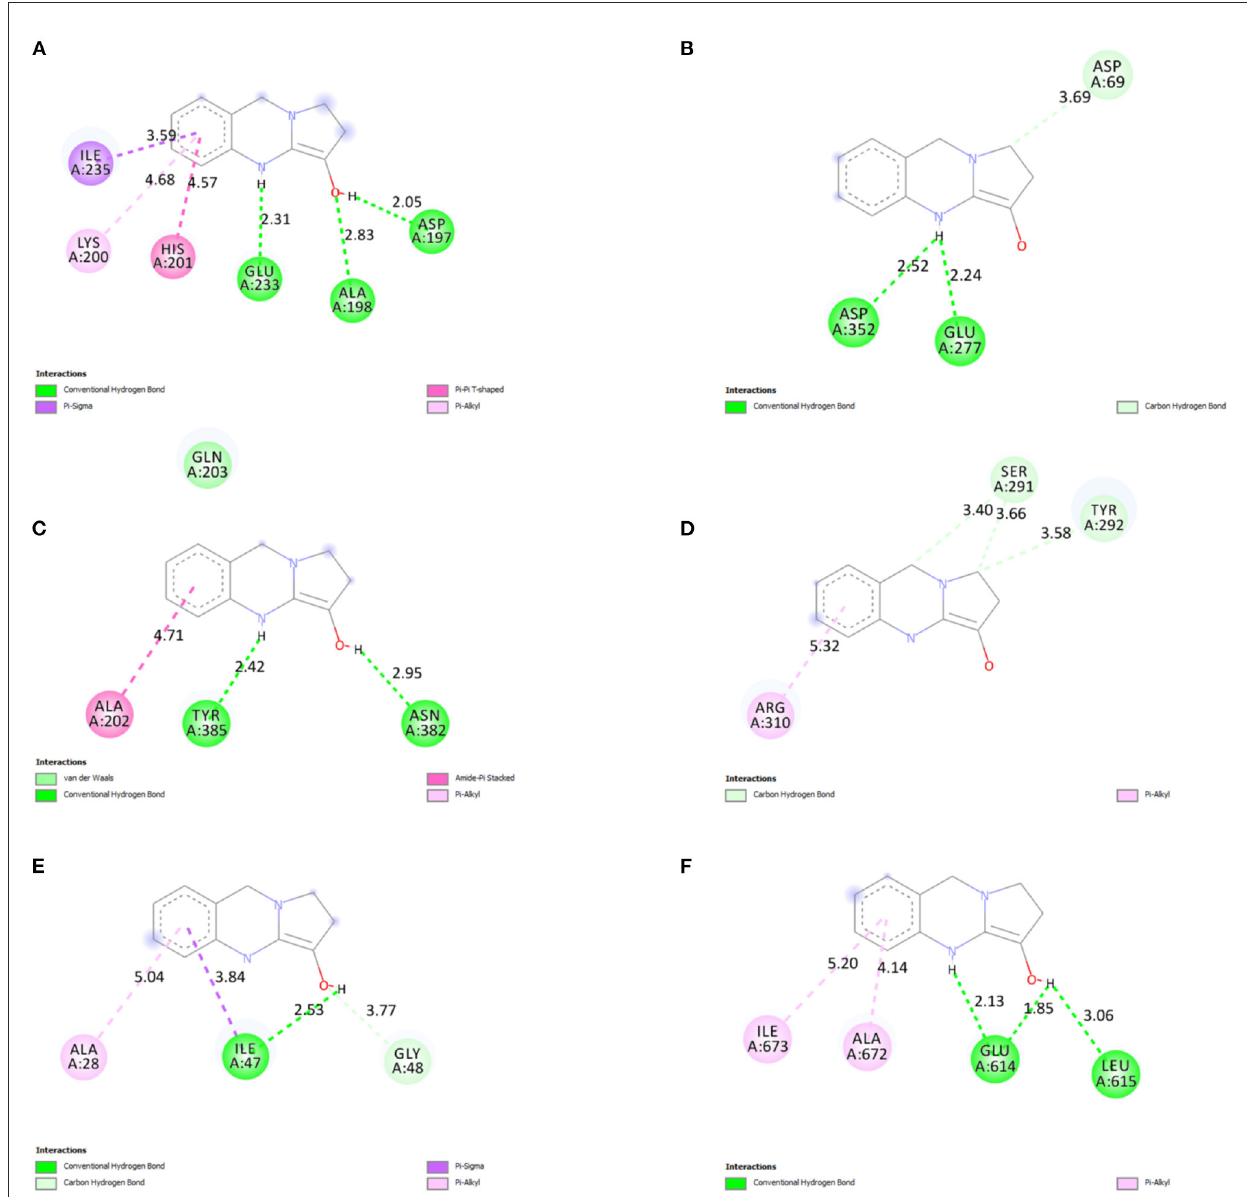
FIGURE10 2D ligand interactions of vasicine with the different amino acid residues at the active binding sites of (A) α -amylase, (B) α -glucosidase, (C) cyclooxygenase, (D) epidermal growth factor and receptor, (E) HIV protease, and (F)